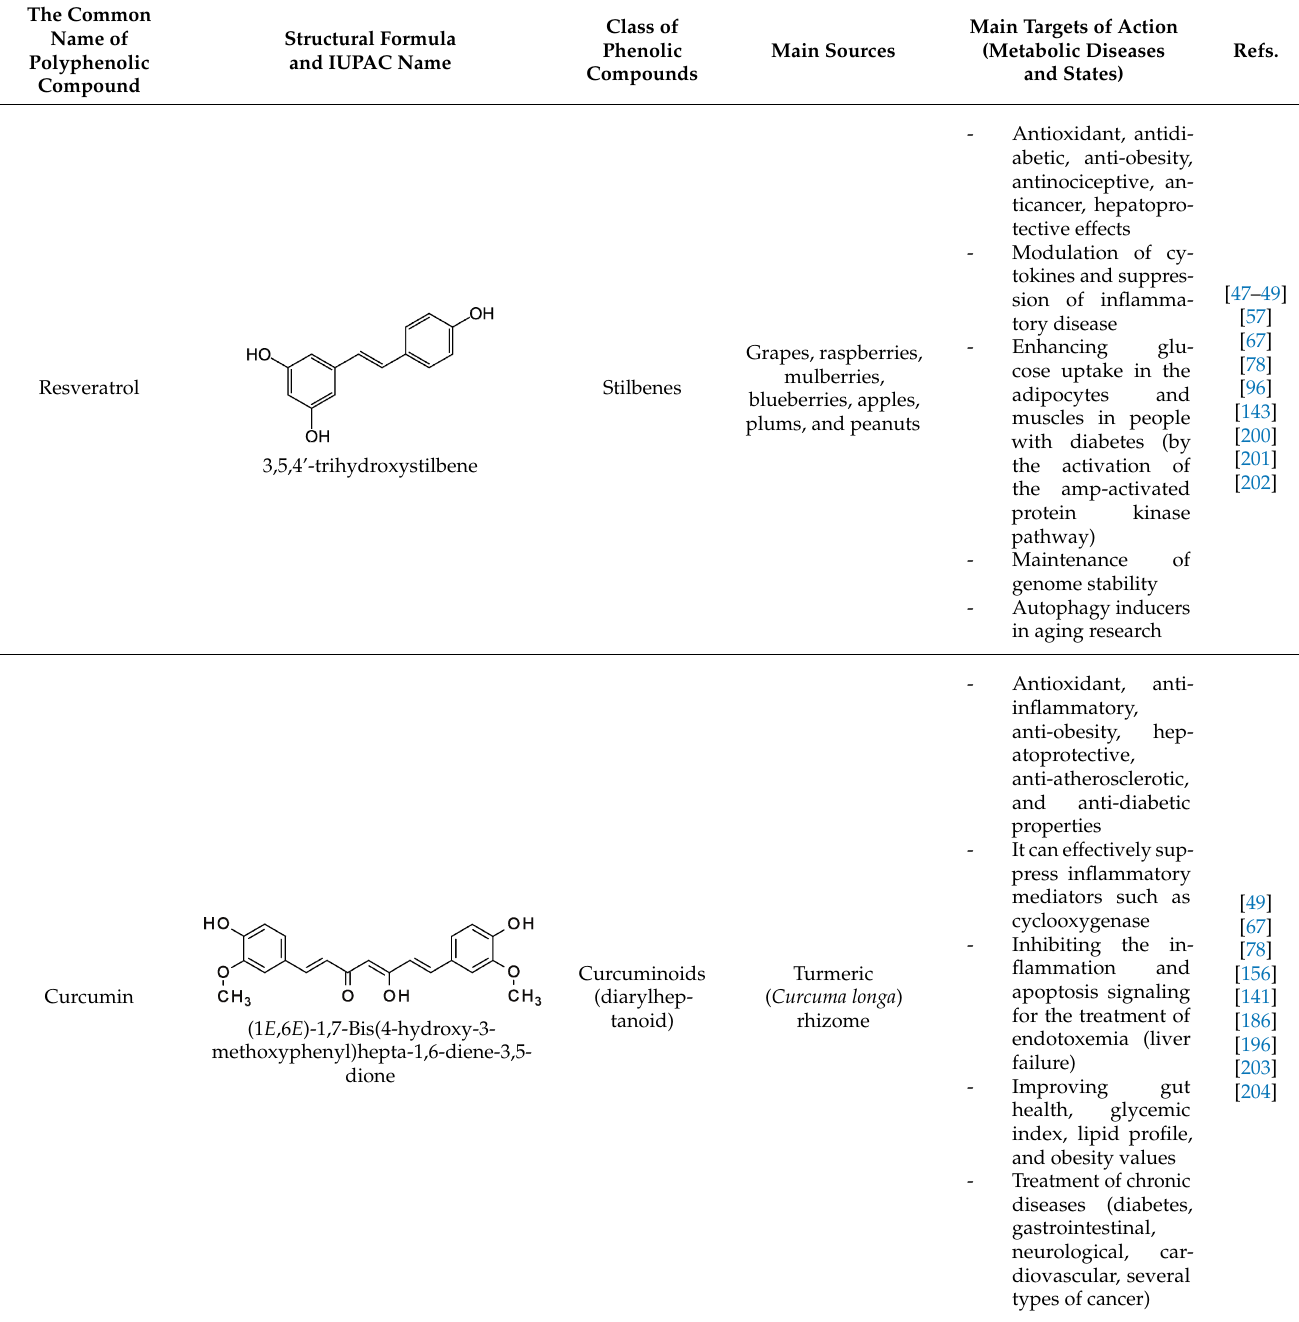
Table 2. The main polyphenols and underlying mechanisms of their pharmacological activity in MtS treatment and prevention.